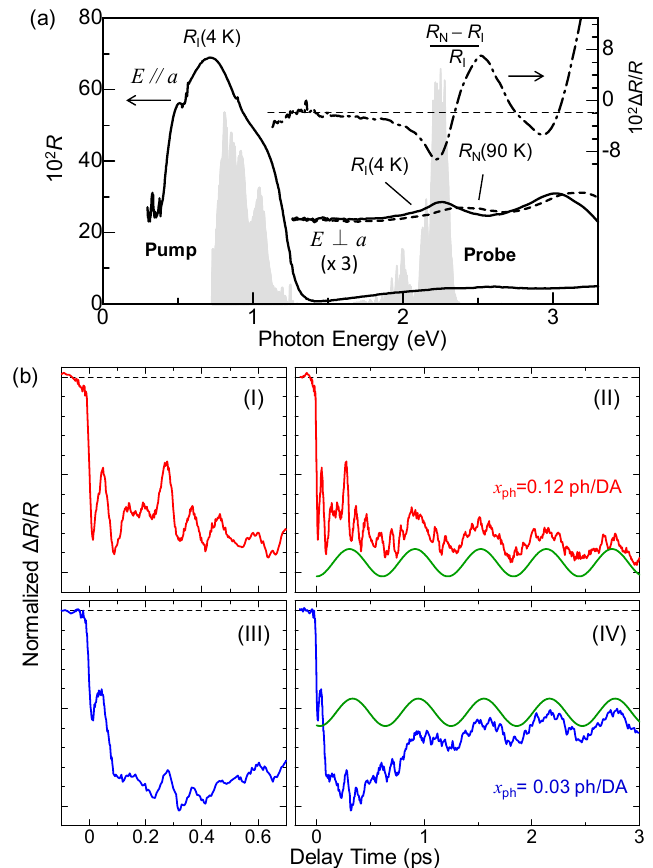
Figure 18. Results of optical-pump optical-reflectivity-probe spectroscopy with the time resolution of ~20 fs in the I phase of TTF-CA. ( a ) Polarized reflectivity spectra at 4 K (solid lines) and at 90 K (the broken line). A differential reflectivity spectrum, [ R N (90 K) − R I (4 K)]/ R I (4 K), is shown by the dashed-dotted line. Shaded areas show spectra of pump and probe pulses; ( b ) Time evolutions of reflectivity changes ( ∆ R / R ) at around 2.2 eV by a strong excitation with x ph = 0.12 ph/ DA [(I) and (II)] and by a weak excitation with x ph = 0.03 ph/ DA [(III) and (IV)]. Green lines in (II) and (IV) show waveforms of − cos( ω t ) with ħω = 55 cm − 1 .